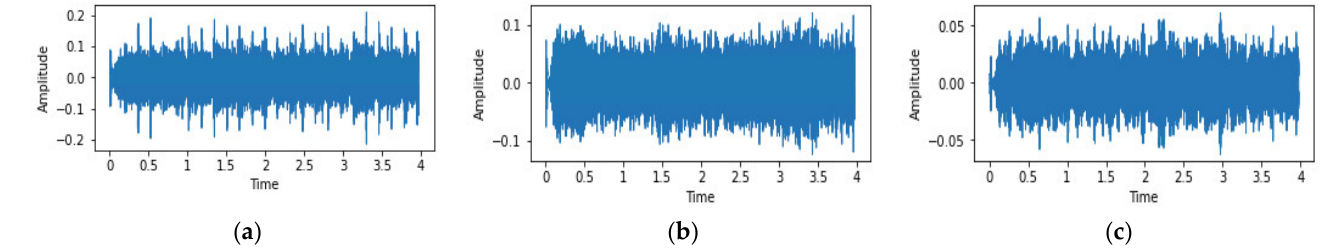
Figure 6. Sound signal data should be listed as: ( a ) fault; ( b ) normal; ( c ) silence.